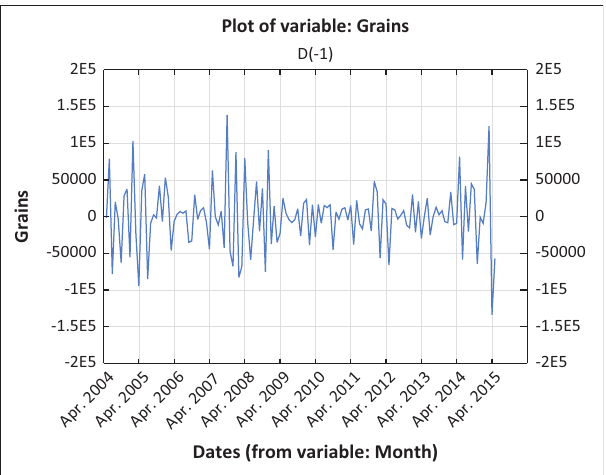
FIGURE 3: Tonnages of grains imported through the bulk grain terminal in the Port of Cape Town between April 2004 and May 2015.